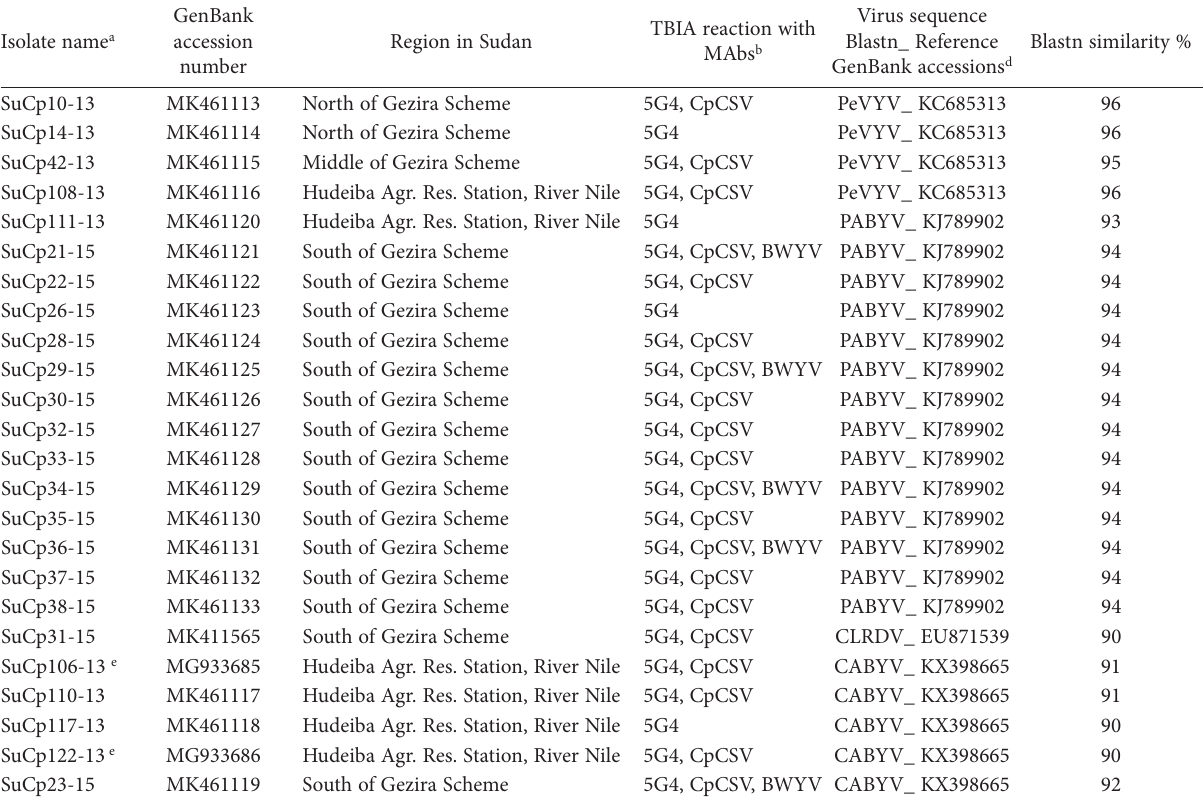
a The last two numbers refer to year of collection. b Information of MAbs are given in Table 3. Virus acronym used is CpCSV: Chickpea chlorotic stunt virus; BWYV: Beet western yellows